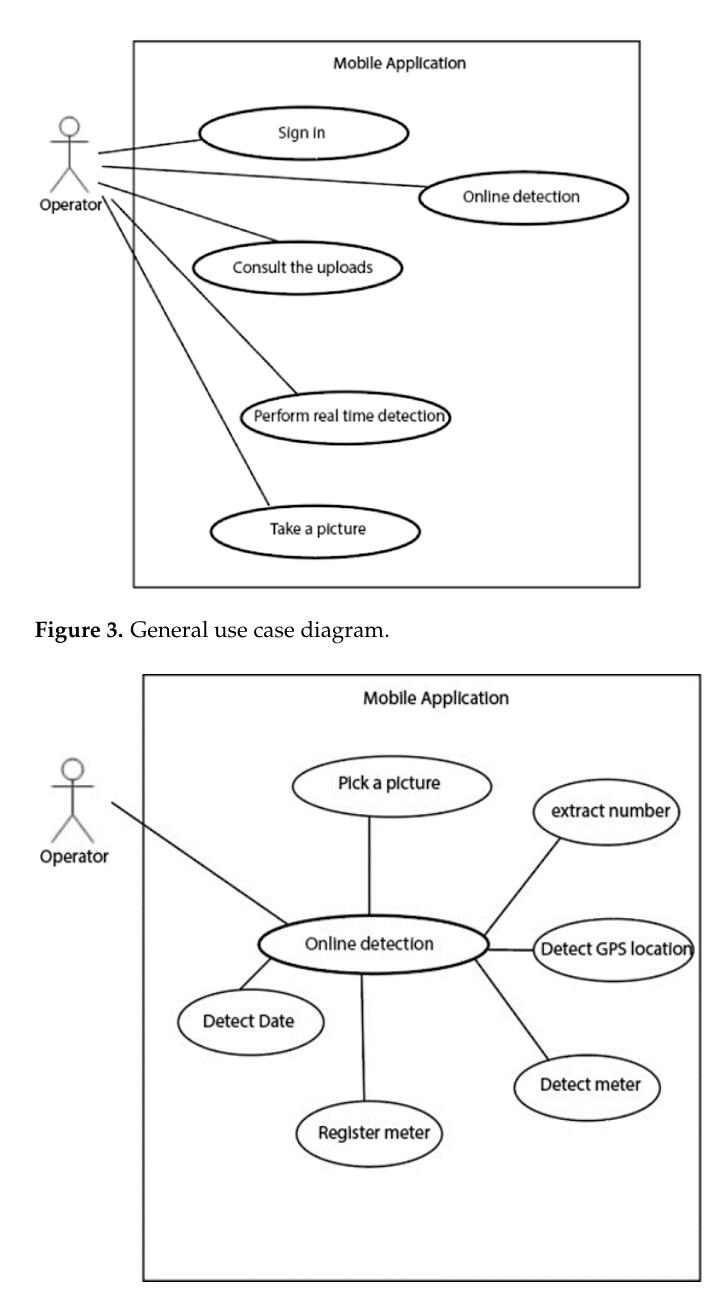
Figure 4. Online detection’ use case diagram.